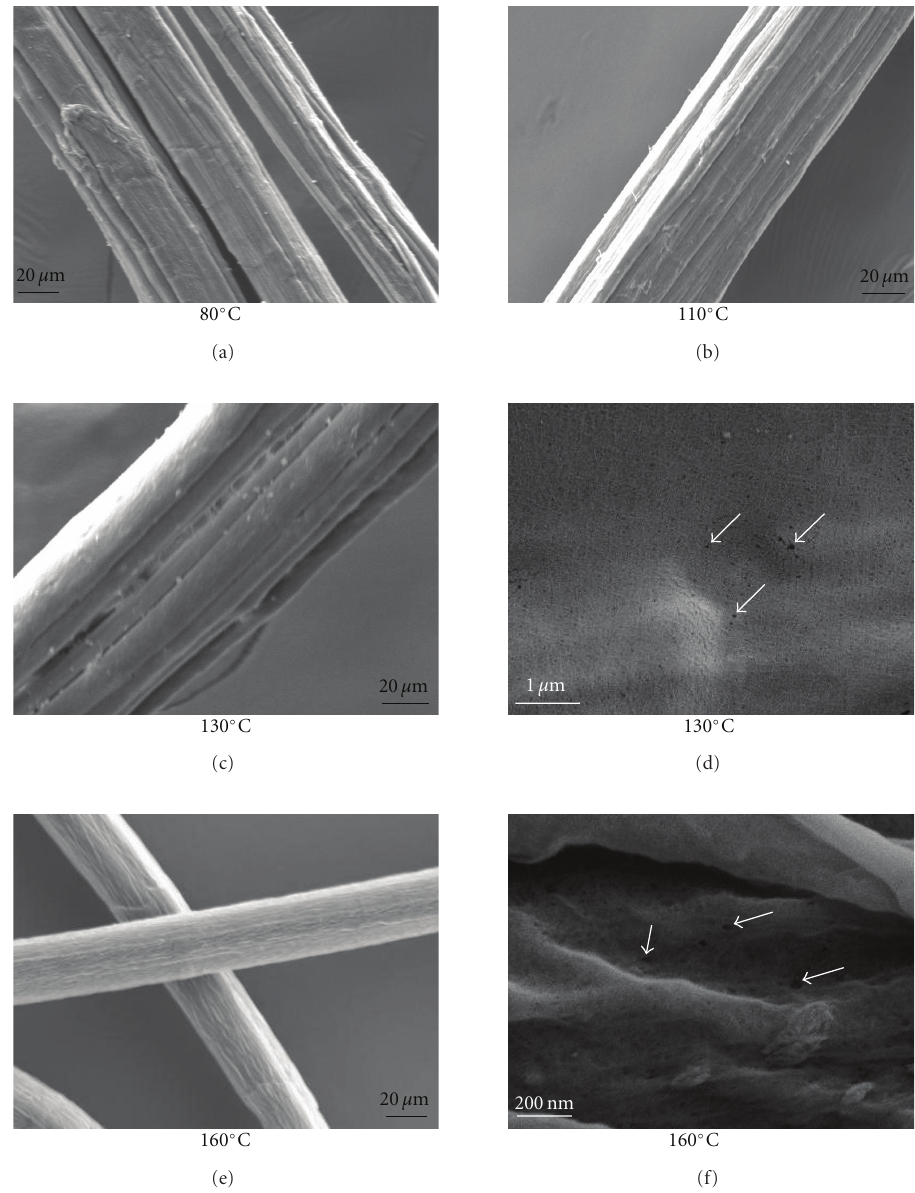
Figure 3: SEM images of the digested fibers. (The arrows designate the